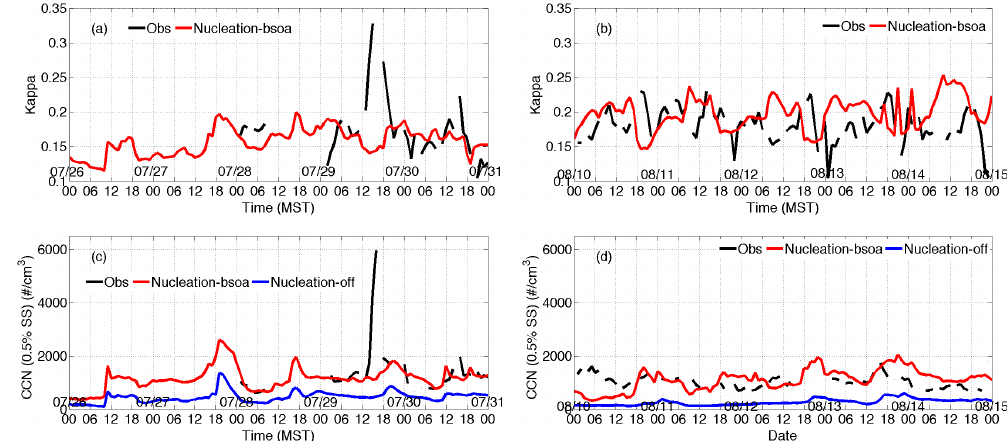
Figure 10. Observed and predicted (Nucleation-bsoa) (a, b) volume-averaged hygroscopicity (kappa) and (c, d) CCN concentrations at high supersaturation condition (0.5% SS) from 26–30 July and 10–14 August 2011. The blue line shows the results without nucleation within Figure 10: Observed and predicted (Nucleation-bsoa) (a,b) volume-averaged hygroscopicity PBL from “Nucleation-off” model (Kappa) and (c,d) CCN concentrations at high supersaturation condition (0.5% SS) from 26-30 July and 10-14 August 2011. The blue line shows the results without nucleation within PBL from “Nucleation-off” model run.